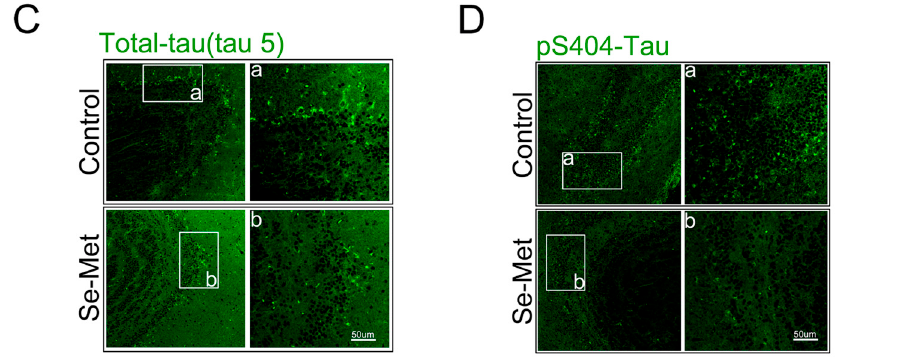
Figure 3. Se-Met treatment attenuated tau expression and hyperphosphorylation in 3 × Tg-AD mice. ( A , B ) Western blot analysis of total tau and phosphorylated tau at Ser404 and Ser422 showed that the levels of total tau, tau-pS404, and tau-pS422 decreased significantly in the OB of Se-Met-treated mice. Quantitative results were normalized against the levels of α -tubulin. Values were expressed as percentages in comparison with the control (set to 100%) and presented as the group mean ± SEM ( n = 6). * p < 0.05, ** p < 0.01 vs. the control group; ( C , D ) Immunofluorescence results showed Se-Met could reduce the pathological epitope of total tau and tau-pS404 compared with the control mice in the OB (a,b: high magnification images of the regions of OB). Scale bar, 50 µ m.